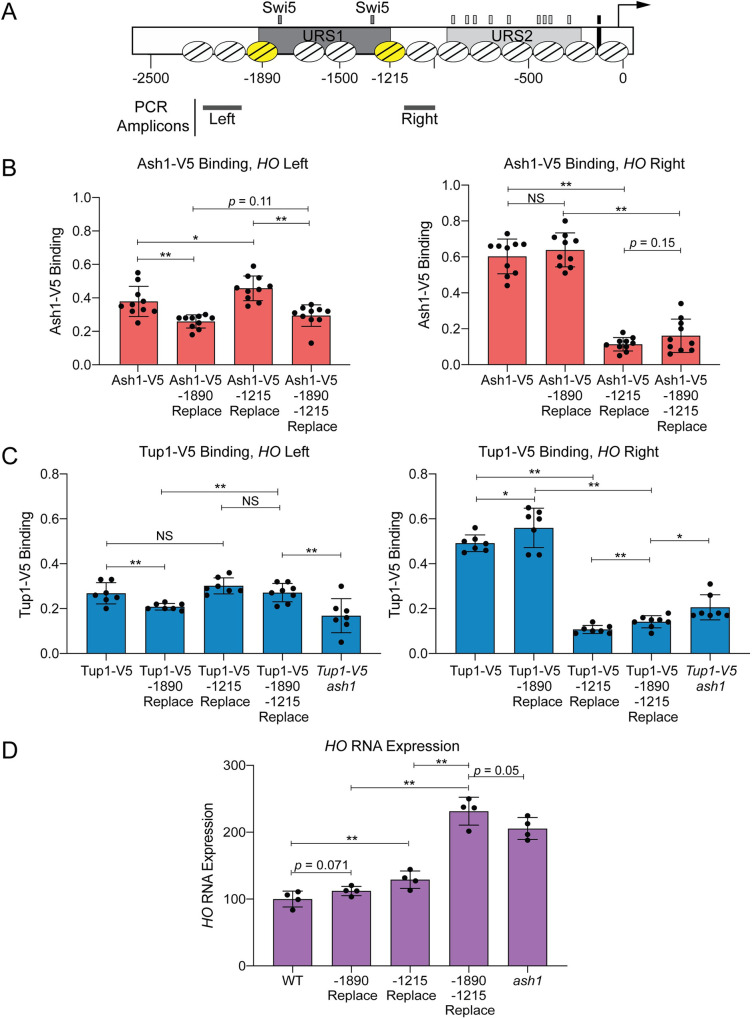
Ash1 and Tup1 association with the HO promoter occurs within two nucleosomes that flank the NDRs containing Swi5 binding sites.(A) A schematic of the HO promoter shows upstream regulatory sequences URS1 and URS2, Swi5 binding sites (dark gray small rectangles; within URS1), SBF binding sites (light gray small rectangles; within URS2), and the TATA element (black small rectangle). Positions of nucleosomes from MNase-Seq data [5] are shown as ovals with slanted lines. The two nucleosomes substituted with CDC39 sequence (-1890 and -1215) are indicated in yellow. Positions of the Left and Right PCR amplicons are shown as gray bars. (B) Nucleosome substitutions reduce Ash1 binding. Ash1-V5 ChIP analysis at the HO promoter, showing enrichment upstream of the -1890 nucleosome (“-1890 Upper”; Left; -2195 to -1998) and downstream of the -1215 nucleosome (“-1215 Lower”; Right; -1137 to -978). “Replace” indicates that the sequence of the nucleosome listed (either -1890 or -1215) was substituted with the sequence of a nucleosome from the CDC39 ORF. Binding at each HO site for each sample was normalized to CLN3 as a positive reference control and its corresponding input DNA. Each dot represents a single data point, and error bars reflect the standard deviation. ** p < 0.01, * p < 0.05. (C) Nucleosome substitutions reduce Tup1 recruitment. Tup1-V5 ChIP analysis at the HO promoter, performed as in B, using TEC1 as a positive reference control. (D) Substitutions at both nucleosomes increases HO expression to the level observed in an ash1 mutant. HO mRNA levels were measured, normalized to RPR1, and expressed relative to wild type. Each dot represents a single data point, and error bars reflect the standard deviation. ** p < 0.01, * p < 0.05.